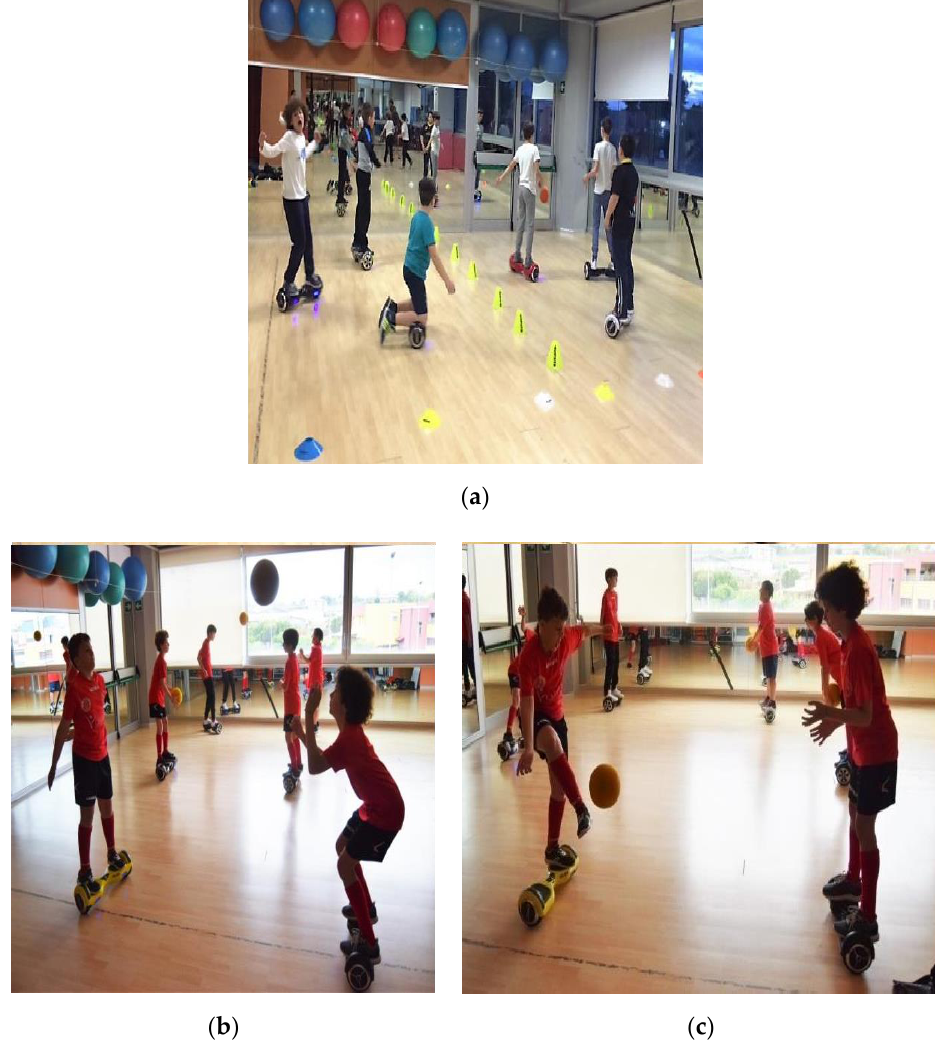
Figure 1. Exercises on the hoverboard performed by the + group. ( a ) slalom; ( b ) throws; ( c ) dribbles.